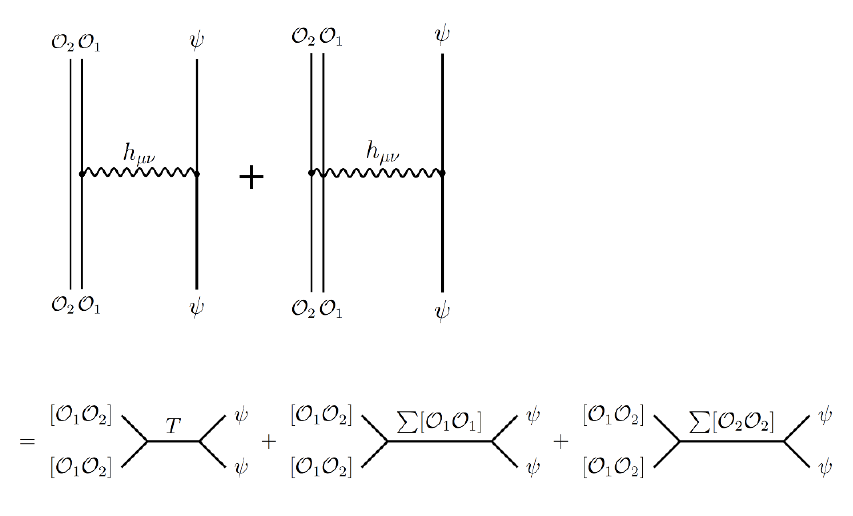
Figure 2 . The correlator acting is completely determined from the above Witten diagrams. For [ and/or ℓ , the left hand side should be acted on by the appropriate derivative operator.